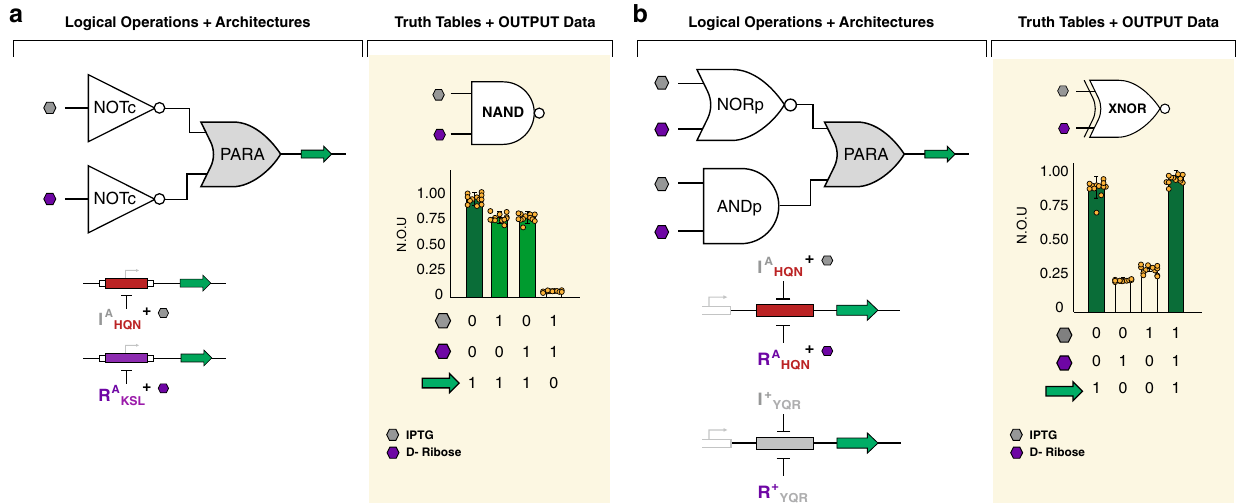
Fig. 8 Transcriptional NAND and XNOR gates. Combinatorial logic in the parallel (PARA) architecture allows the construction of the NAND and XNOR operations. In plots, vertical-bars display normalized output units (N.O.U.), the standardized mean fl uorescence intensity (de fi ning the measure of centre) as a fraction of the maximum observed for that operation ±1 S.D., and truth tables are shown (below) corresponding to bars (above) for different ligand conditions. Results shown are from n = 12 independent biological replicates with similar results, dots shown for each replicate. a The NAND operation was achieved with two NOTc operations in PARA. In one channel, I A(9) HQN (from Rondon and Wilson 44 ) regulated GFP via a core O ttg operator; in a second channel, R A(1) KSL regulated GFP via a core O agg operator. In the presence of neither ligand, transcription was fully-permitted in both channels (relative OUTPUT = 1), while in the presence of only one ligand, IPTG or D-ribose, one channel was anti-induced, but, in the other, transcription was fully-permitted (relative OUTPUT~ 1). Only in the presence of both ligands were both channels anti-induced, leading to full inhibition of gene expression. b The XNOR operation was constructed with a NORp and ANDp operation in PARA. In one channel, I A(9) HQN and R A(1) HQN simultaneously regulated GFP via a proximal O ttg operator in a SE-PA architecture; in the second channel, I + YQR and R + YQR regulated GFP via a proximal O SYM operator (see Fig. 6b for this individual BUO). In the presence of either no ligand present, or both ligands present, one channel fully-permitted transcription, while the other was attenuated, leading to relative OUTPUT = 1. In the presence of only one ligand, however, both channels were attenuated, as simultaneously, either I + YQR and R A(1) HQN or R + YQR and I A(9) HQN were interacting with their respective operators, causing relative gene output to be